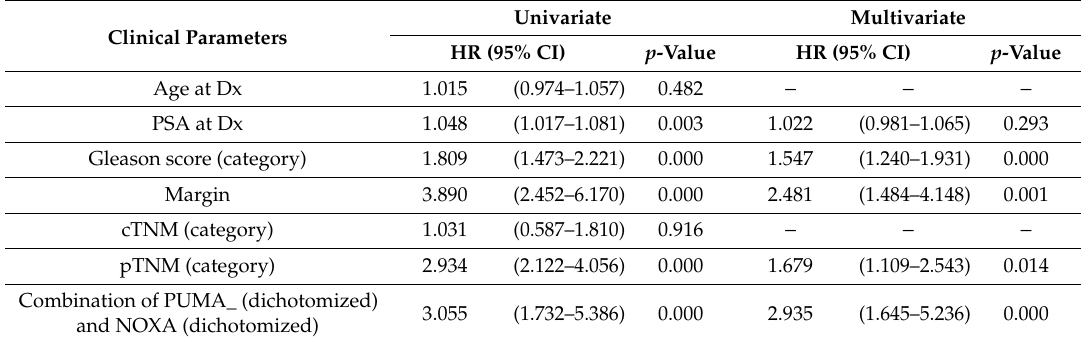
Table 3. Univariate and multivariate Cox regression analyses of clinical parameters and combination of PUMA and NOXA expression in benign epithelial cells to predict biochemical recurrence at 3 years. Clinical